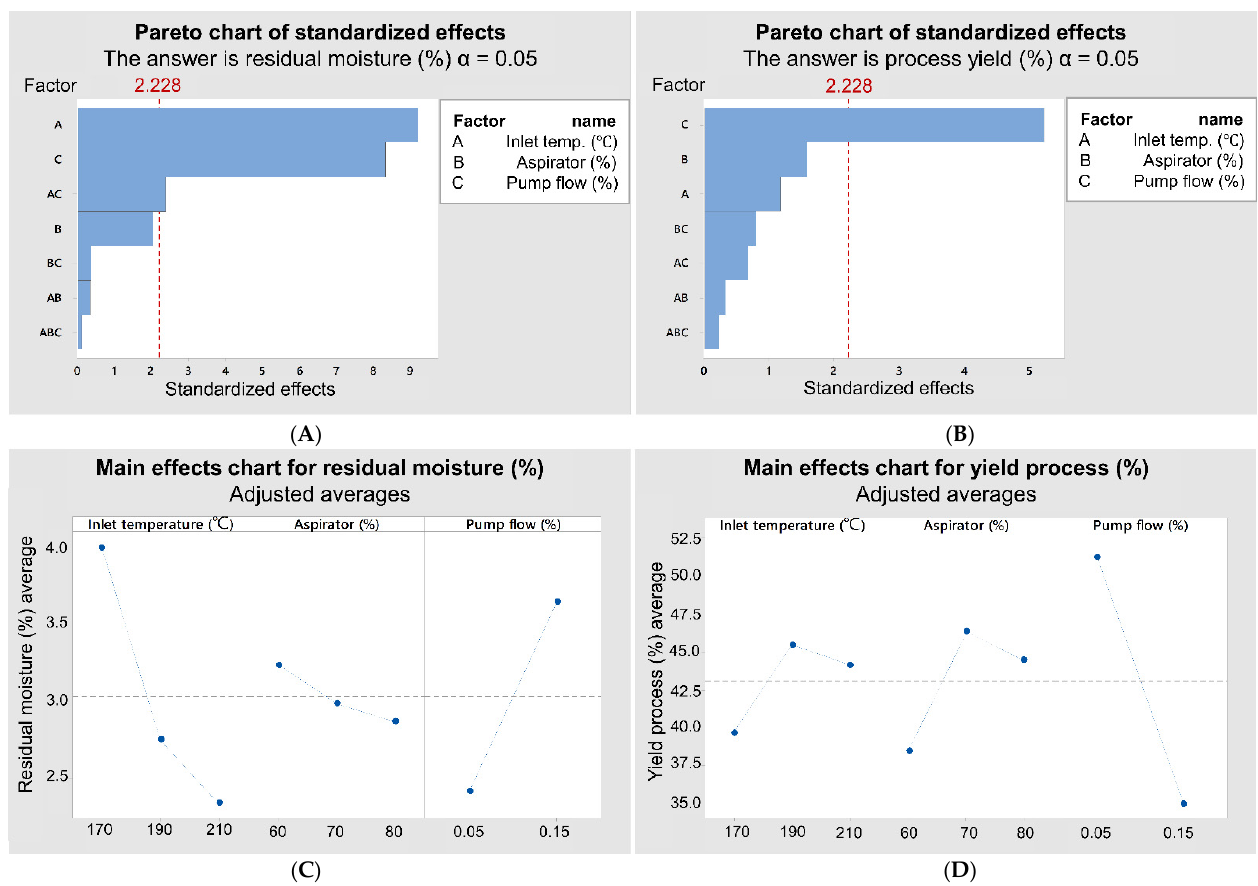
Figure 3. Pareto chart representing the impact of critical synthesis parameters under residual moisture ( A ) and process yield ( B ) and graphic representation of individual factors and their impact on the residual moisture ( C ) and yield process ( D ) factors.